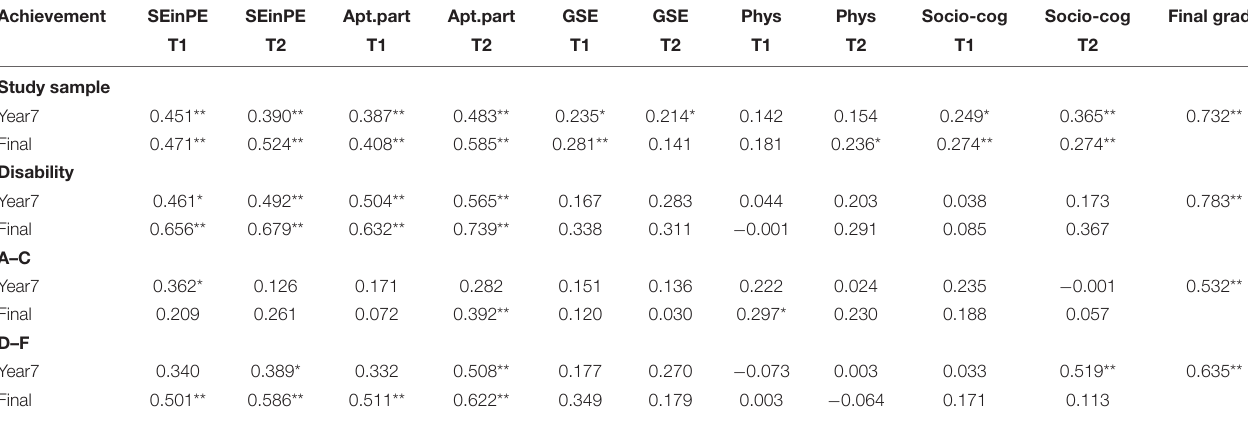
TABLE 8 | Correlations over time of achievement in PE with students’ perceived self-efficacy (PE-specific and general), aptitude to participate, and functioning (physical and socio-cognitive). Achievement SEinPE SEinPE Apt.part